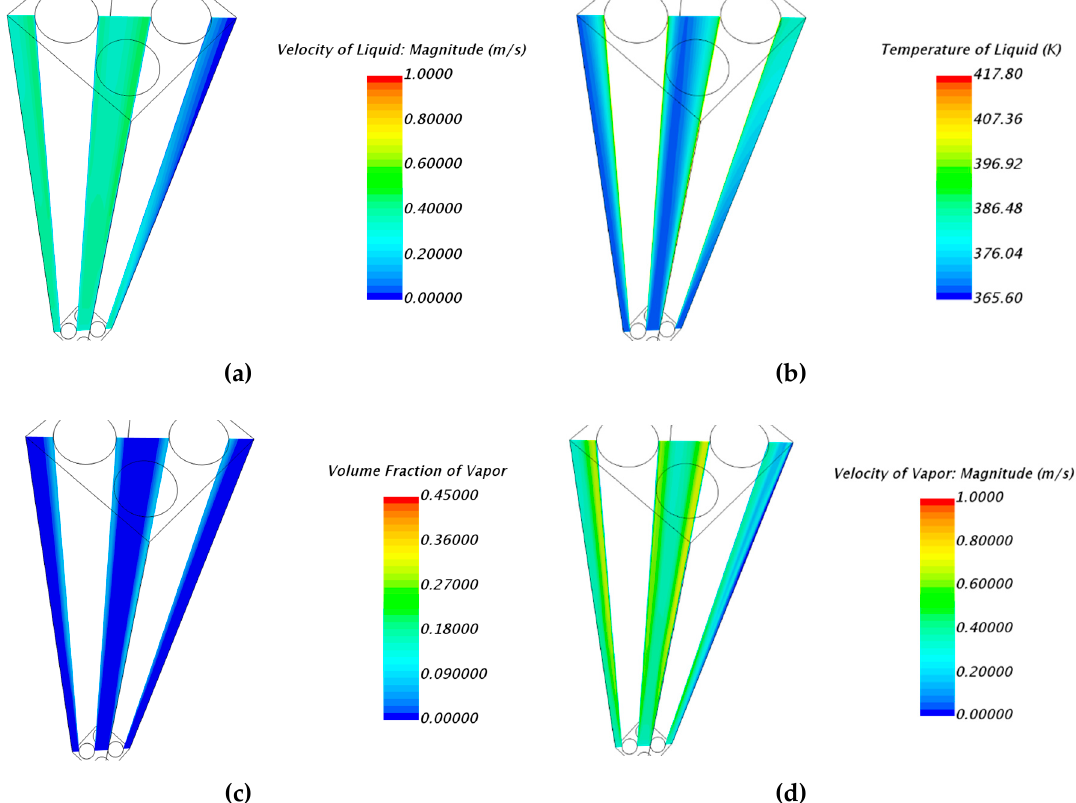
Figure 14. Distribution contour in Case 4: ( a ) velocity of liquid, ( b ) temperature of liquid, ( c ) volume fraction, and ( d ) velocity of vapor on the vertical plane at the wall edge.